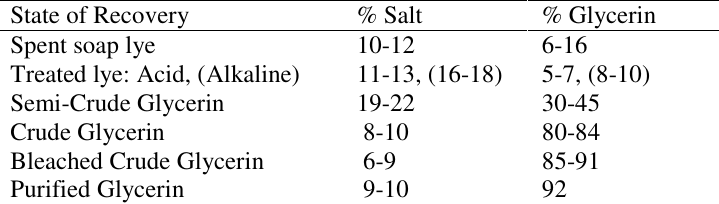
Table 2. Glycerin Producers Association Standards for glycerin recovery 7